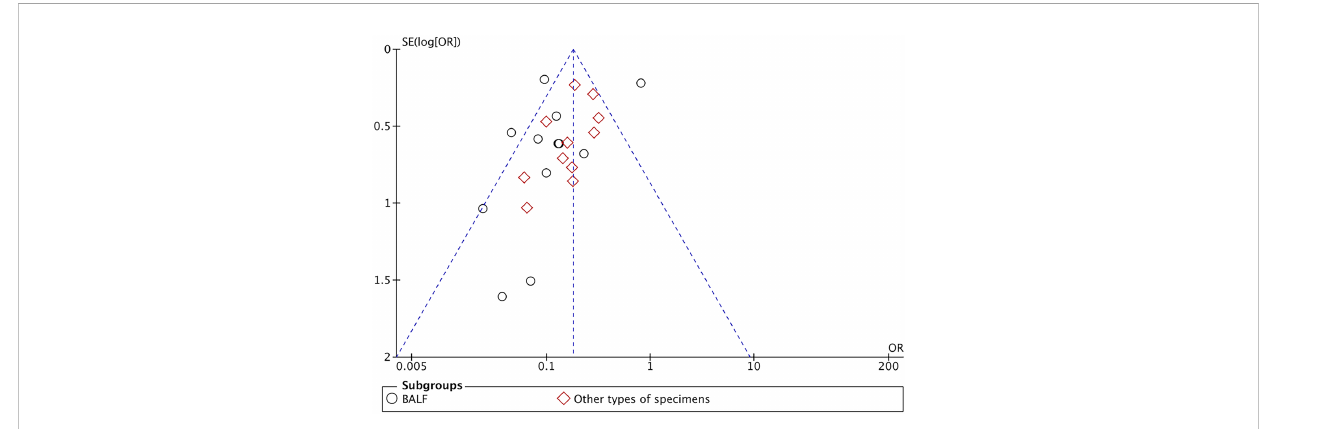
FIGURE 4 Funnel plot of pathogen detection positive rate between mNGS and conventional methods